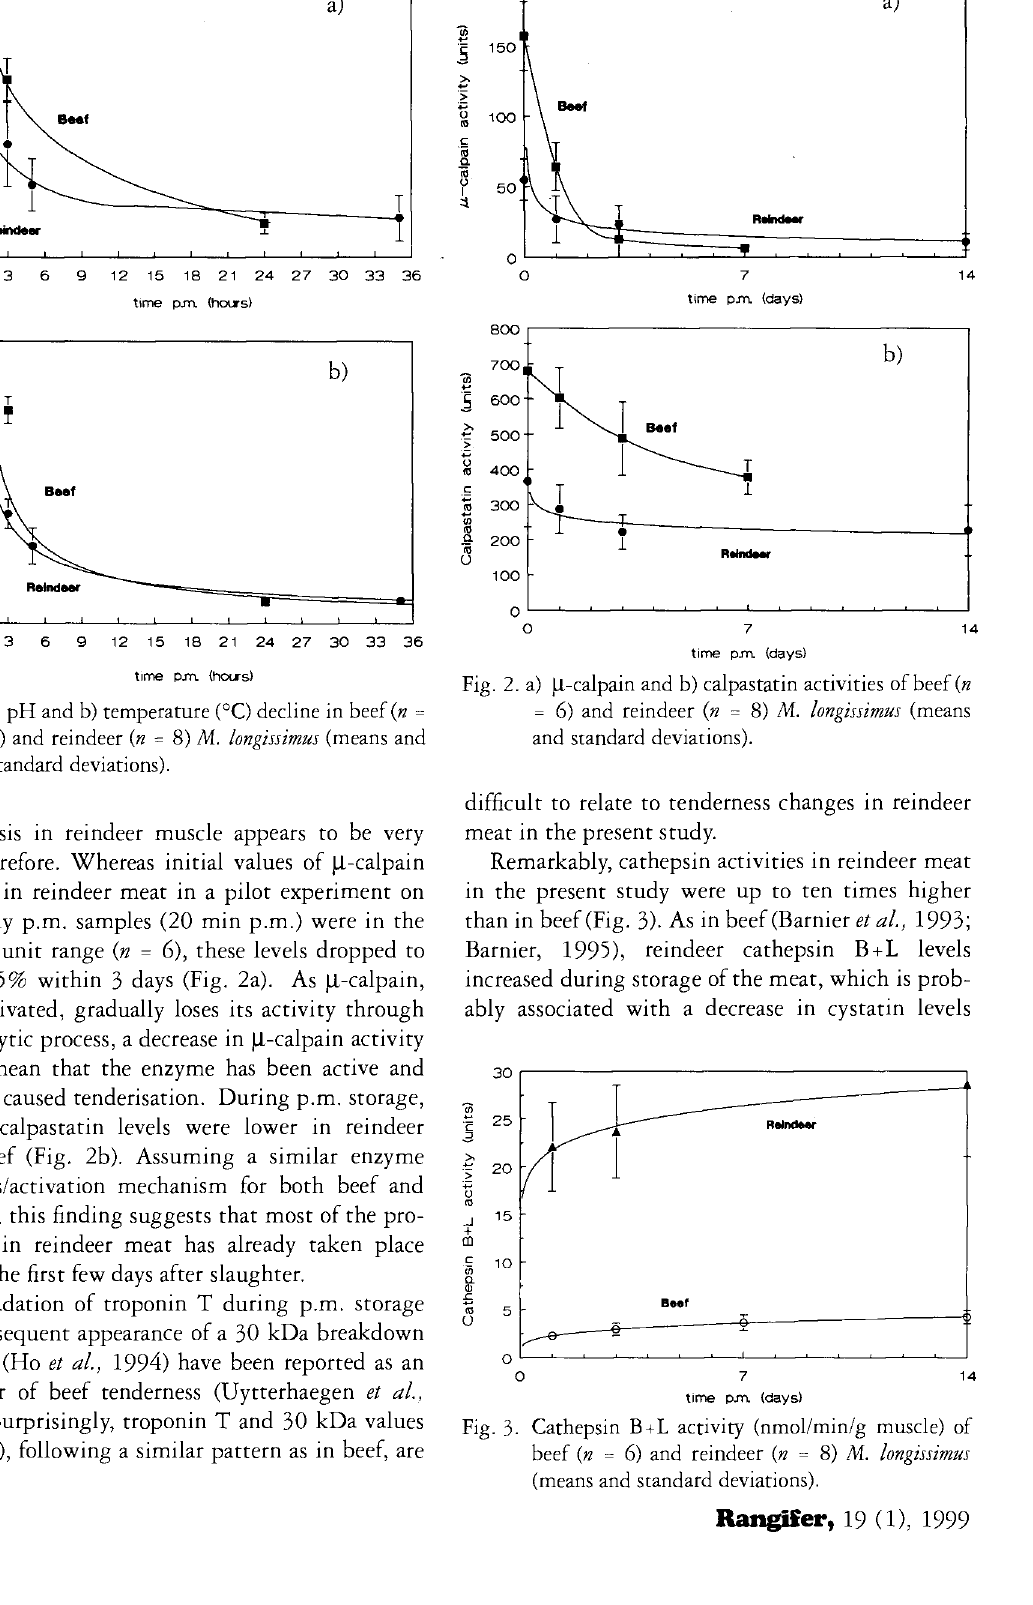
0 7 14 time pm (days) 3. Cathepsin B+L activity (nmol/min/g muscle) of beef (» = 6) and reindeer (» = 8) M. longissimus (means and standard